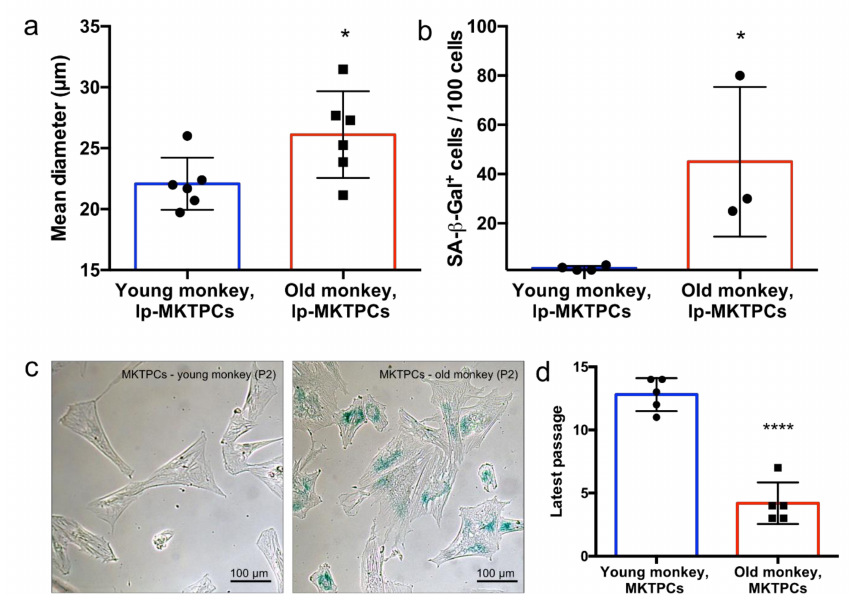
Figure 5. ( a ) Cells size measurement of MKTPCs from young vs. old monkeys revealed significantly increased cell size of MKTPCs from older monkeys. ( b ) Proportion of β -galactosidase-positive MKTPCs from young vs. old monkeys. ( c ) Light micrograph of senescence-associated β -galactosidase staining of MKTPCs from young (3 years) and old (11 years) monkey in passage 2. ( d ) Maximal passage numbers before o ff set of cell division. Columns indicate the mean; bars indicate the standard deviation.